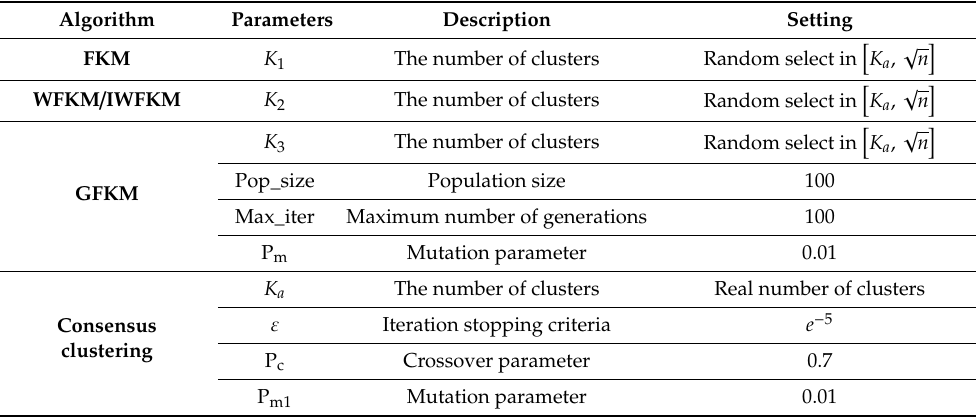
Table 3. Parameter setting of the proposed algorithm and the comparison algorithms.